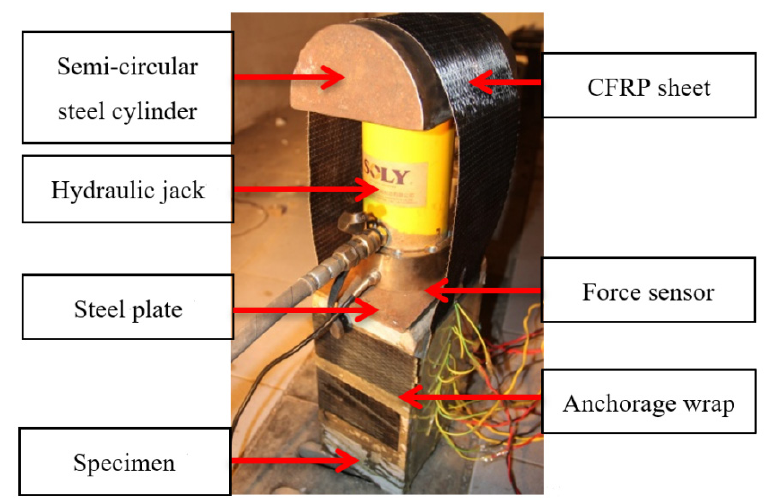
Figure 2. The self-balancing double shear lap test loading device.